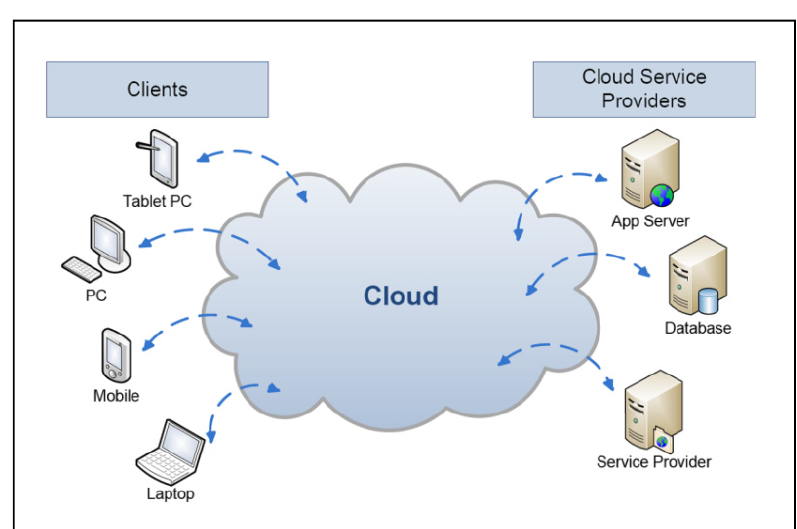
Figure 1. The concept of cloud